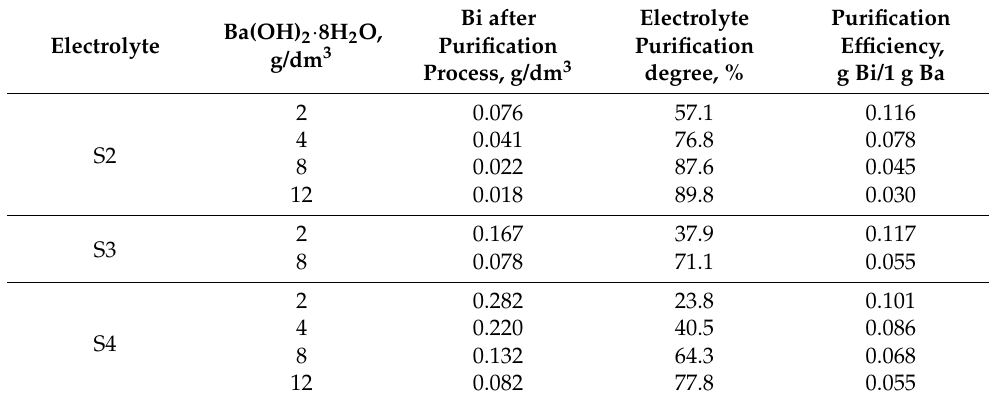
Table 5. Bi concentration in electrolytes after purification, electrolyte purification degree and the number of grams Bi removed by 1 g of Ba ions (purification efficiency) depending on initial Bi concentration in electrolyte and amount of barium hydroxide octahydrate additive.